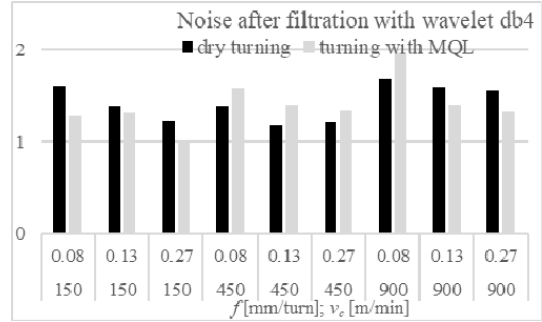
Figure 20. Noise and disturbance values in composite turning with polycrystalline diamond insert (CD10), obta– ined through filtration with wavelet Daubechies 4 (db4). Table 6. Measured cutting forces Fc , measurement-based load constancy factor values and after filtration with wavelets and noise values for aluminium composite turning with polycrystalline diamond tool.